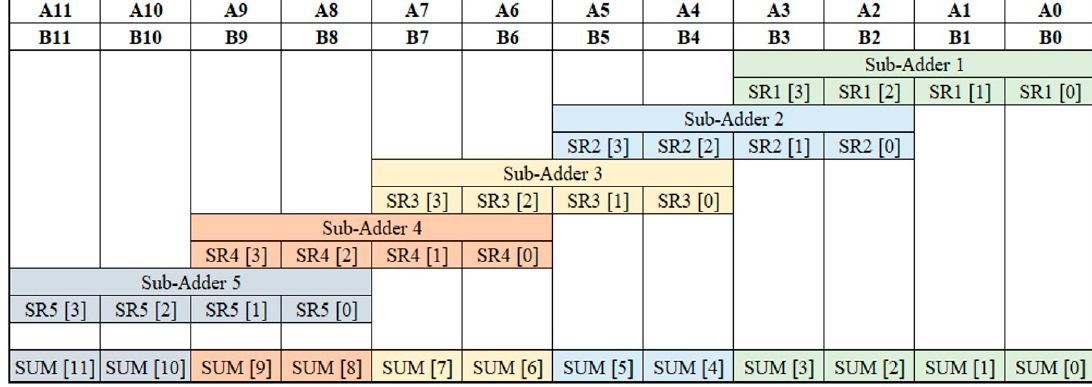
Figure 7. A 12-bit GeAr adder in R2 P2